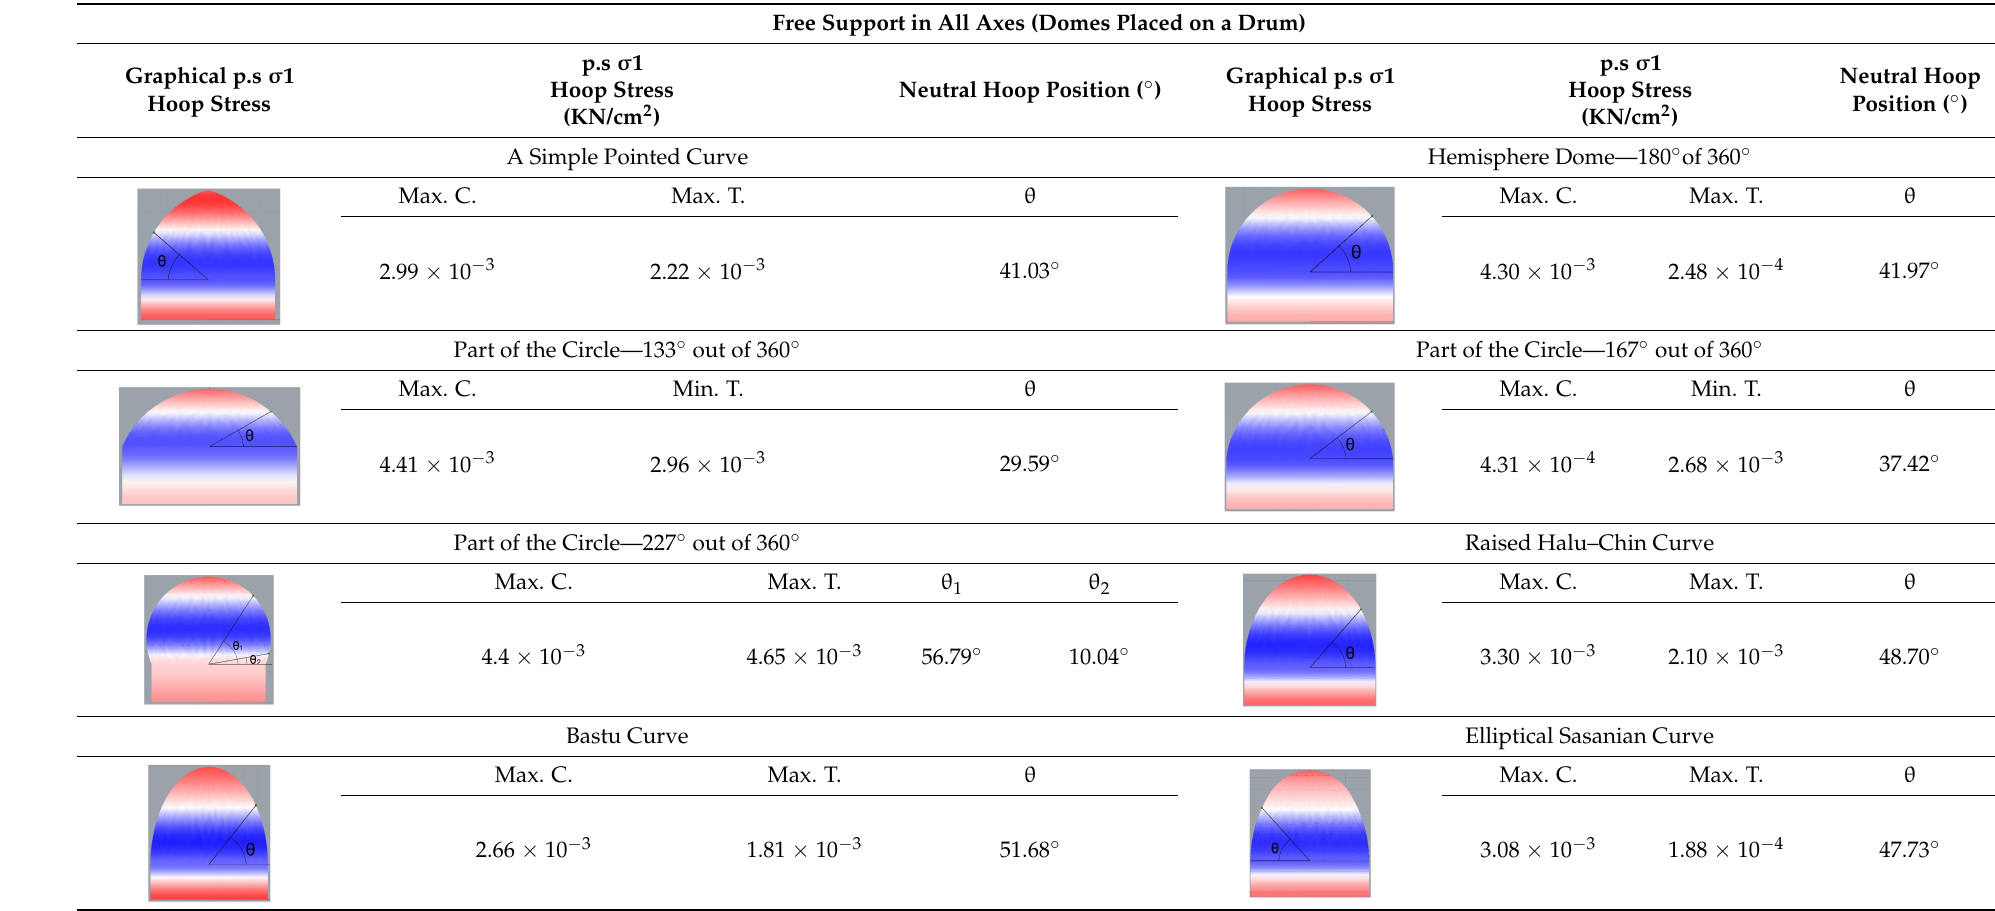
Table 8. Analysis of domes—R m = 5 m, t dome = 90 cm, t dome /d m = 0.09, H drum = 3 m, t drum = 90 cm, R drum = 5 m. Free Support in All Axes (Domes Placed on a